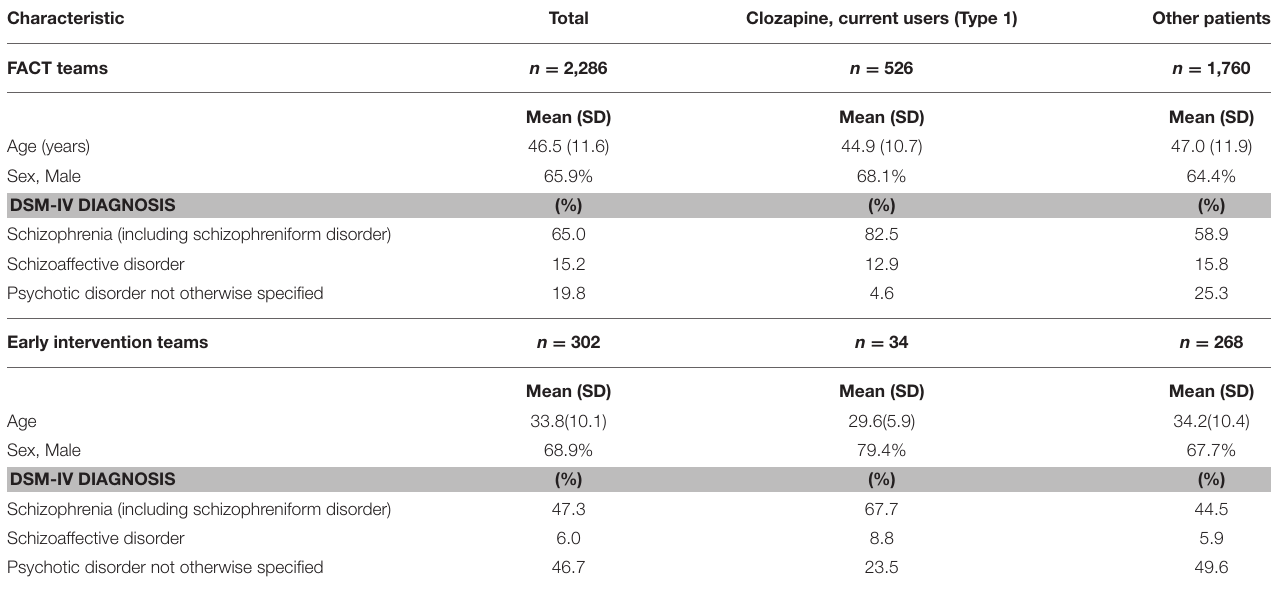
TABLE 1 | Demographic and clinical features of 2,588 patients with Non-Affective Psychotic Disorder, treated by 20 Functional Assertive Community Treatment (FACT) teams and three Early Intervention teams in the Netherlands, 2016. Characteristic Total Clozapine, current users (Type 1)